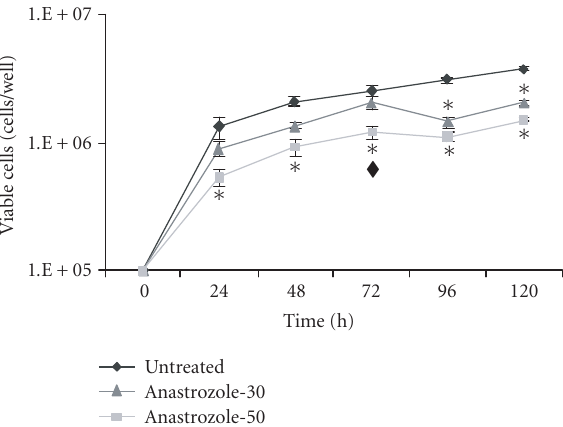
Figure 3. Cell growth kinetics of untreated and anastrozole- treated 4T1 (30 or 50 µ g/mL). Stars indicate a statistical dif- ference in number of viable cells from the untreated groups ( P ≤ . 05), as determined by the Student t test. A diamond in- dicates a statistical di ff erence between the two anastrozole con- centration groups. Bars represent ± SEM.